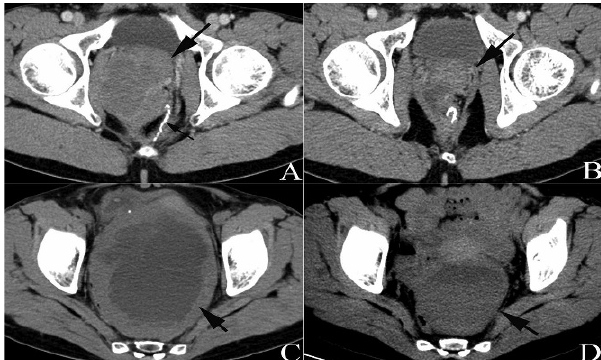
Figure 3 - Patient no. 13 underwent resection of rectal GIST eight years prior (the thin arrow in A shows the anastomotic nail) and the tumor was reduced by 61% after six months of IM treatment at a dosage of 400 mg per day (indicated by thick arrows in AB). CT scans showed a huge mass located in the pelvic cavity, presenting as mixed cystic lesions (C). The tumor size decreased after 4 months of IM treatment (D) and the patient received surgical treatment at 4.5 months after initiation of IM treatment.